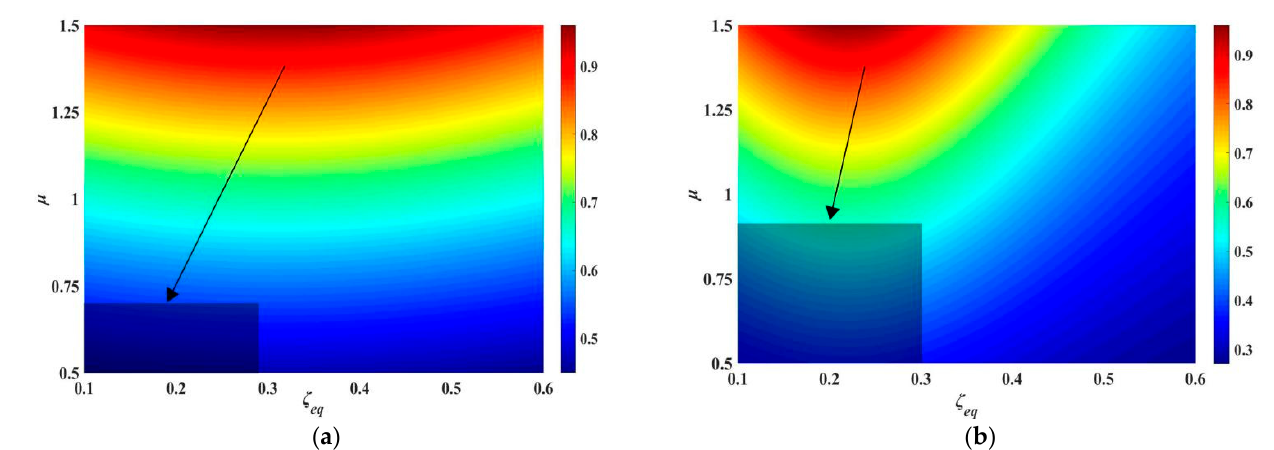
Figure 11. Contour plot of γ SF of HB–2 : ( a ) κ = 0.05; ( b ) κ = 0.1 .